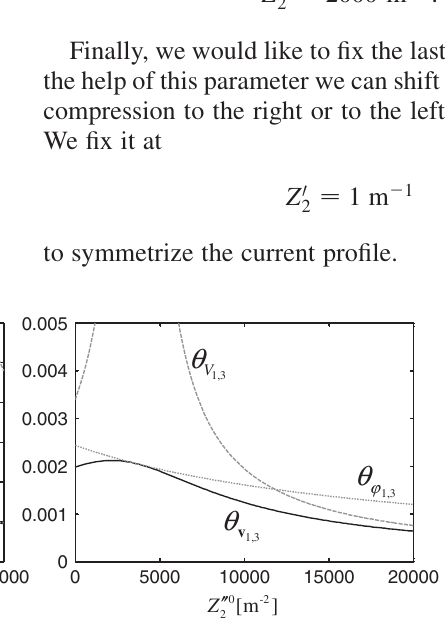
vs global compression parameter Z 00 0 1